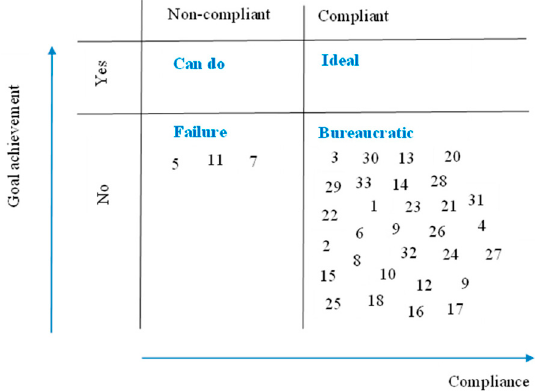
Figure 1. Compliance x goal achievement for the base cases (N = 33).